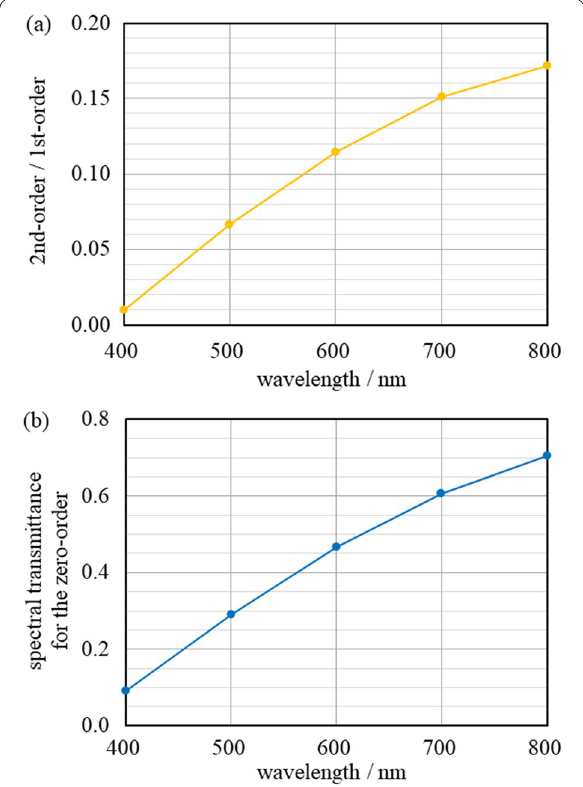
Fig. 6 a The brightness ratio of the 2nd-order to the 1st-order images is plotted against wavelength. The ratios were measured in laboratory calibrations and are used in the correction for the Fig. 5 Images obtained in our laboratory calibration experiments 2nd-order image. b The brightness fraction of the zero-order image for the monochromatic light source. The wavelength is shown on in the zero-, 1st-, and 2nd-order images. The contribution of the other the right side of each frame. The grayscale is inverted. Because of the order images is negligible. The fraction is equivalent to the relative brazed-type grating characteristics, the positive-order images (the left transmittance of the grating for the zero-order if the other factors side in each frame) are brighter than the negative-order images (the that reduce lights (e.g., absorptions in the glass) are independent of right side), and the brightness ratio between the 1st-order images wavelengths. For the calculations in Eq. (2), the fraction was assumed + and the zero-order images depend on wavelengths to be constant at 800 nm and